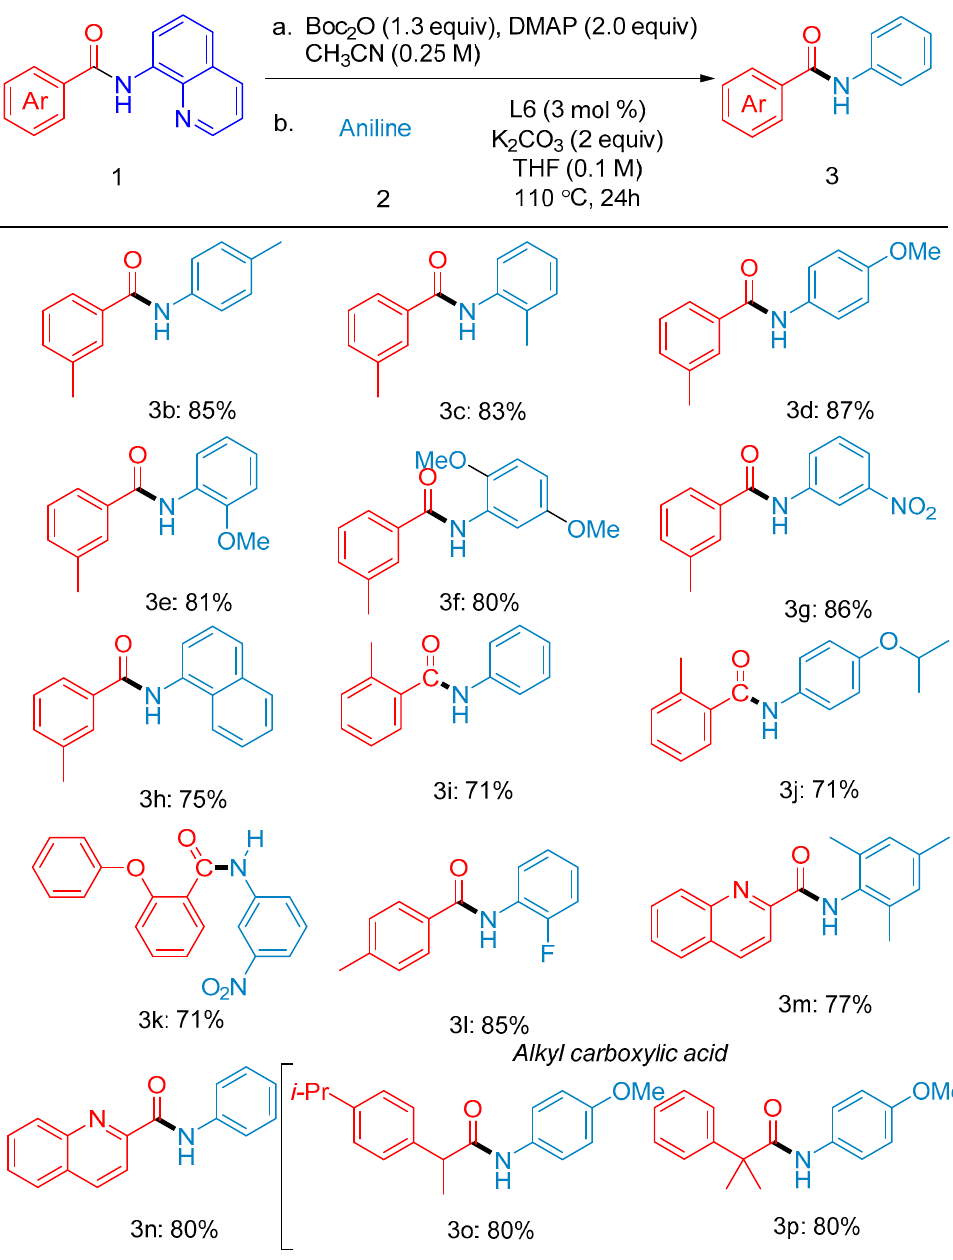
Figure 2. Scope of the transamidation reaction. Conditions: see Supplementary Materials for details.